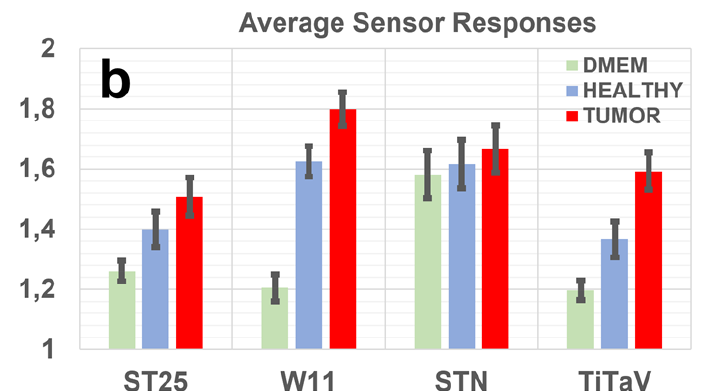
Figure 2. ( a ) Experimental protocol and time-course of a representative sensor response. The response amplitude of the sensor with the highest discrimination power, TiTaV, (titanium, tantalum, and vanadium oxide) is plotted vs. time; the sensor was exposed to the following sample sequence: clean air / DMEM / clean air / healthy sample / clean air / tumor sample / clean air / DMEM / clean air. ( b ) Average sensor responses. Bar graph of the average ratio ( n = 13) between the sensor response to a flux of air containing the gasses exhaled by DMEM (green bars), healthy tissue (light blue), and tumor tissue (red); and its response to a flux of clean air (baseline); error bars represent the standard error. The sensors employed were ST25 (tin and titanium oxide), W11 (tungsten oxide), STN (tin, titanium, and niobium oxide), and TiTaV.